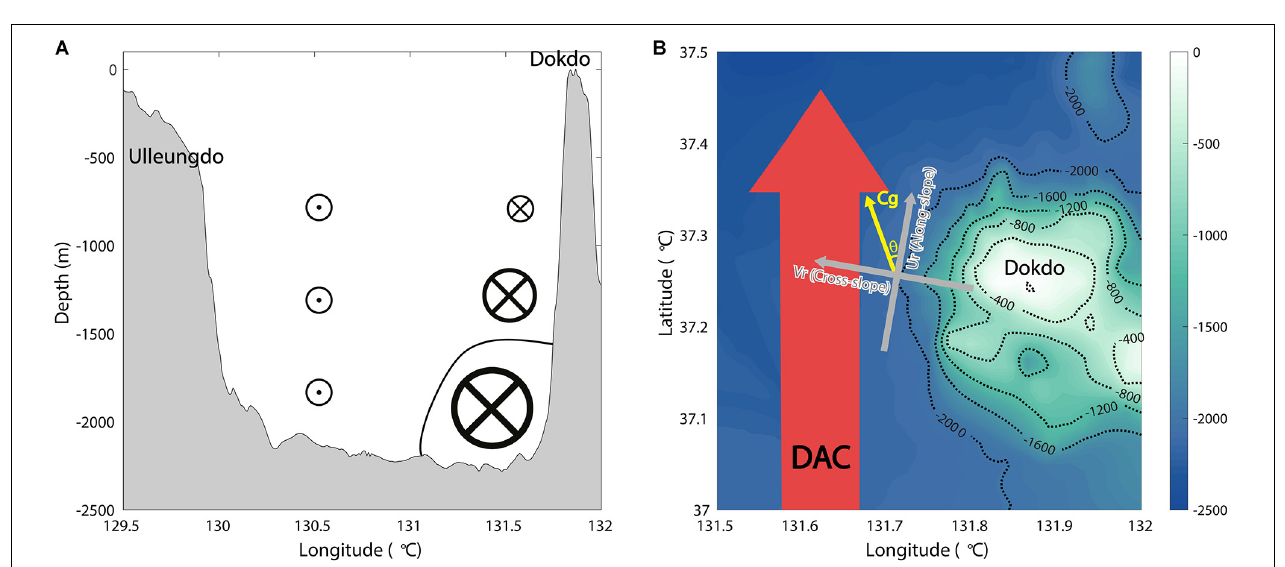
FIGURE 11 | Schematic of the TRWs. (A) Side view at 37.25 ◦ N between Ulleungdo and Dokdo. (B) Detailed bathymetry near Dokdo with isobaths every 400 m. The angle ( θ ) indicates the direction of the wavenumber vector.